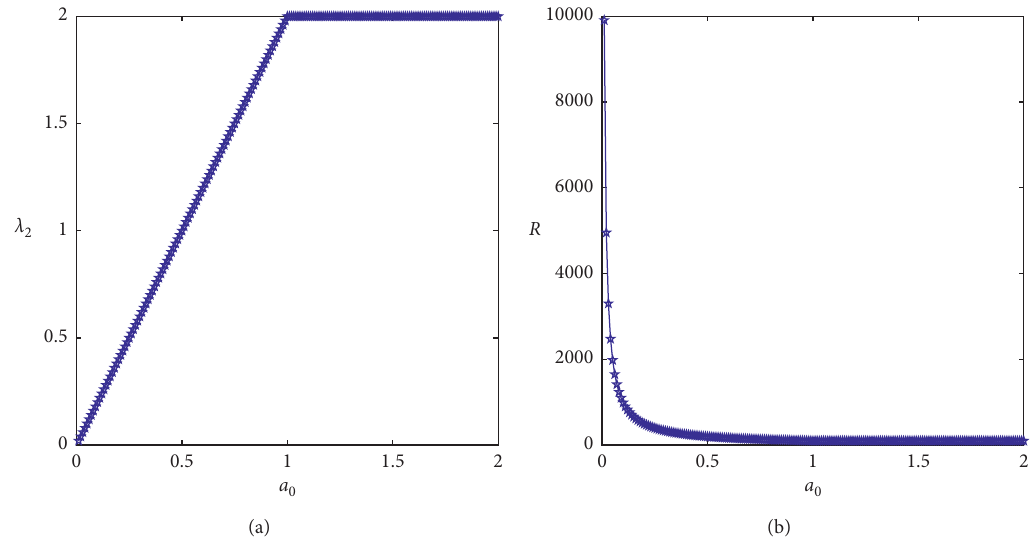
Figure 12: When N is odd, the synchronizability of Network II changes with the intralayer coupling strength a changes with a ( a changes from 0.01 to 2); (b) R changes with a 0 0